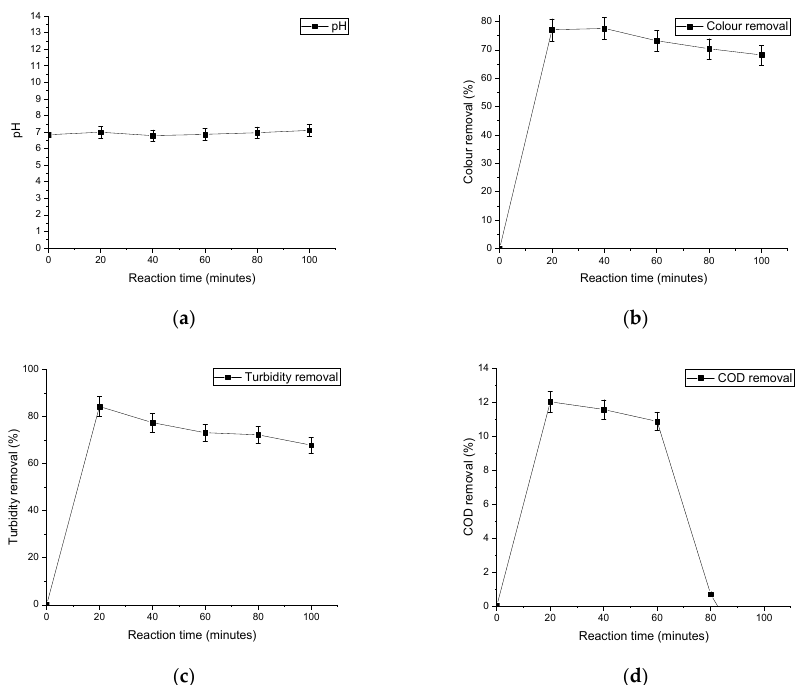
Figure 2. Trends of the effect of reaction time on photocatalysis treatment parameters: ( a ) The effect of reaction time on pH; ( b ) The effect of reaction time on colour removal; ( c ) The effect of reaction time on turbidity removal ( d ) The effect of reaction time on COD removal (mixing speed at 60 rpm and catalyst loading at 0.9 g/L).